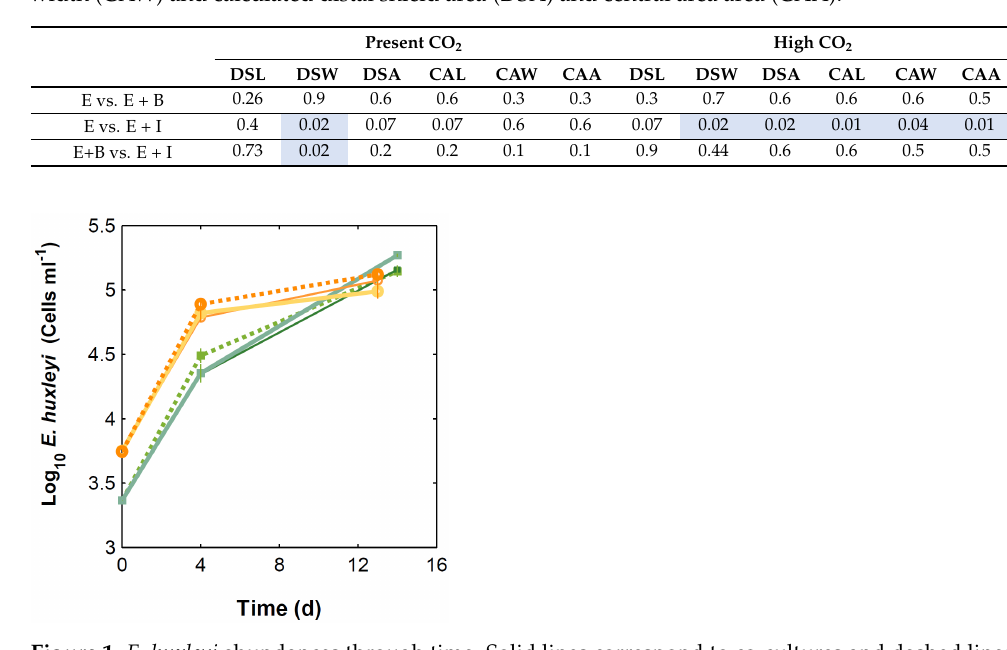
Figure 1. E. huxleyi abundances through time. Solid lines correspond to co-cultures and dashed lines to monocultures, under 475 (green) and 1056 µatm (orange). Thin solid lines correspond to E. huxleyi + Brachybacterium sp.; thicker solid lines to E. huxleyi + I. abyssalis .